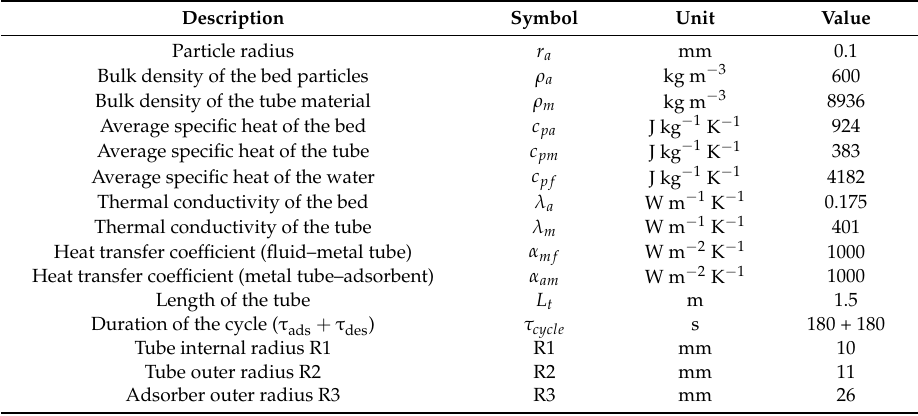
Table 2. Parameters used in the calculation (sourced from [15,34,44,45]).